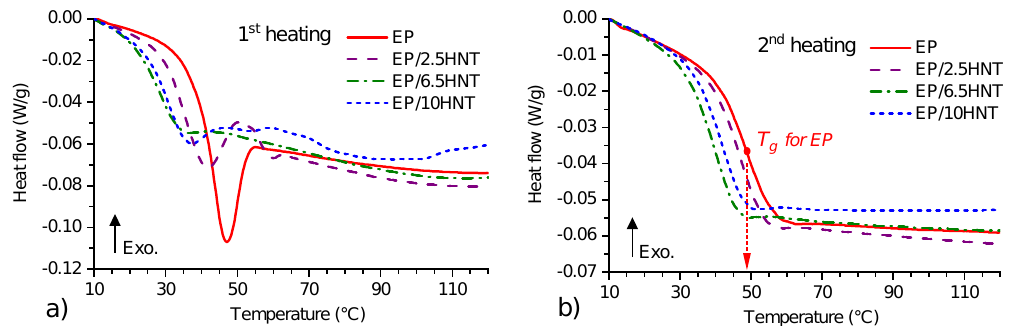
Figure 4. Temperature dependencies of heat flow for ( a ) first heating, and for ( b ) second heating together with highlighted T g for